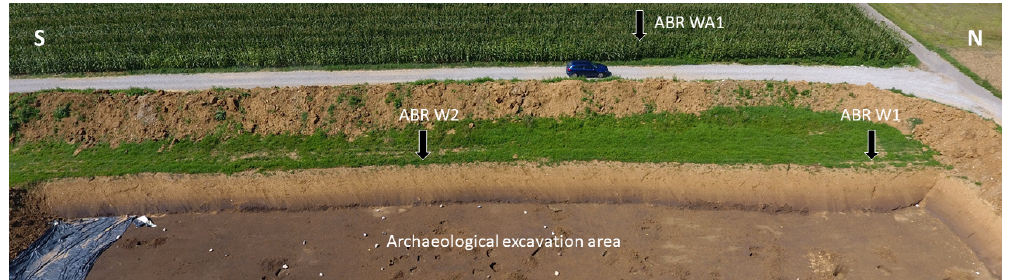
Figure 3. Overview of the western excavation boundary at the ABR site with the colluvial profiles ABR W1, ABR W2 and ABR WA1 and related colluvial horizons ( M ). Photo: Höpfer (2017). The distance between ABR W1 and ABR W2 is about